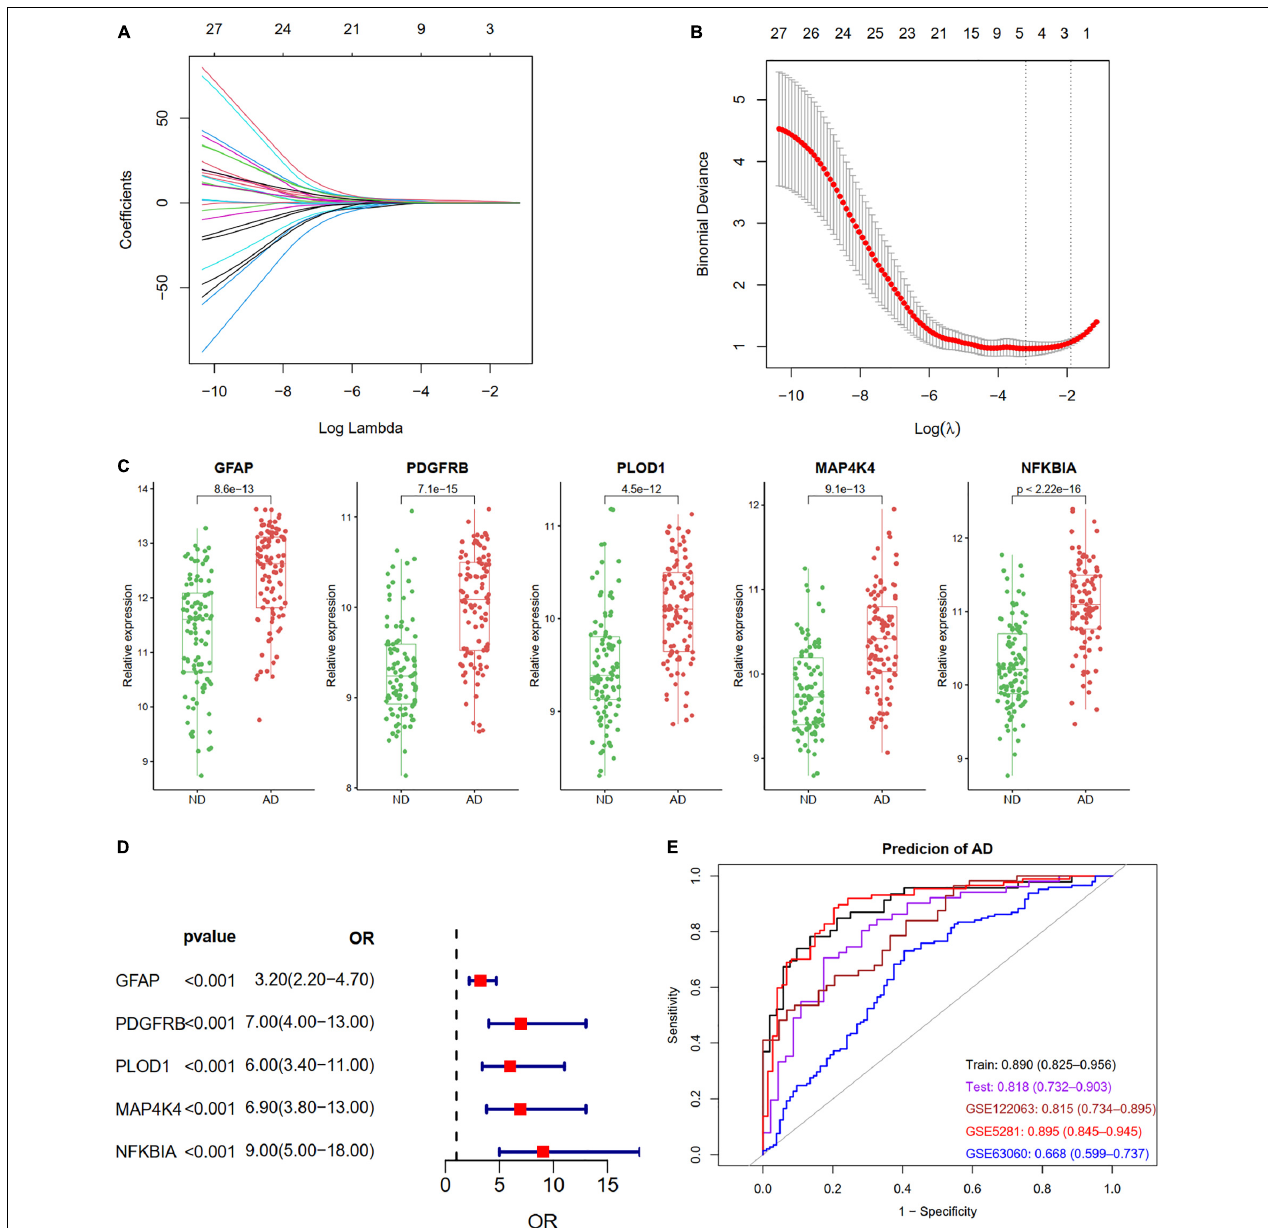
FIGURE 6 | Construction a diagnostic model using the ARDEGs. (A,B) Feature selection by LASSO regression model in train dataset of GSE132903. (A) The coefficients change of different genes with different lambda. (B) By verifying the optimal parameter (lambda) in the LASSO model, the partial likelihood deviance (binomial deviance) curve was plotted vs. log (lambda). Dotted vertical lines were drawn based on 1 SE of the minimum criteria (the 1-SE criteria). Five features with non-zero coefficients were selected by optimal lambda. (C) Boxplot showing the relative expression of the five selected genes in GSE132903. (D) Forest plot of five genes based on univariate logistic regression. (E) ROC curves showing the five ARDEGs diagnostic ability in train and test dataset of GSE132903, GSE122063, GSE5281, and